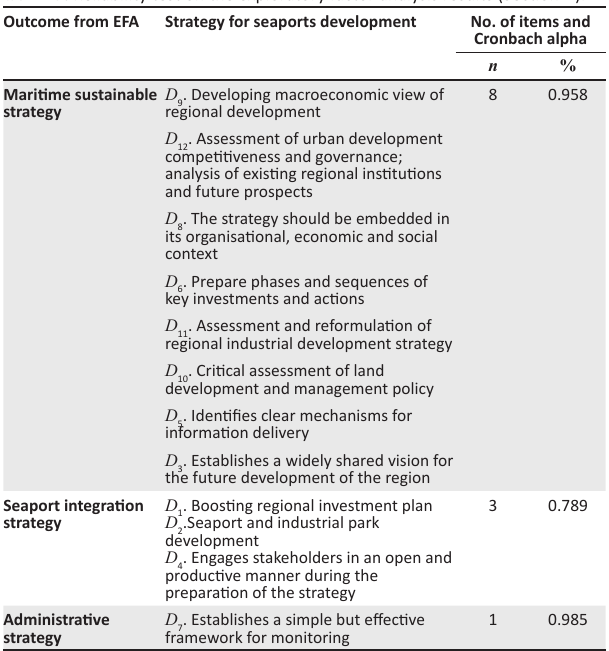
TABLE 7: Reliability test on the exploratory factor analysis results (Section D). Outcome from EFA